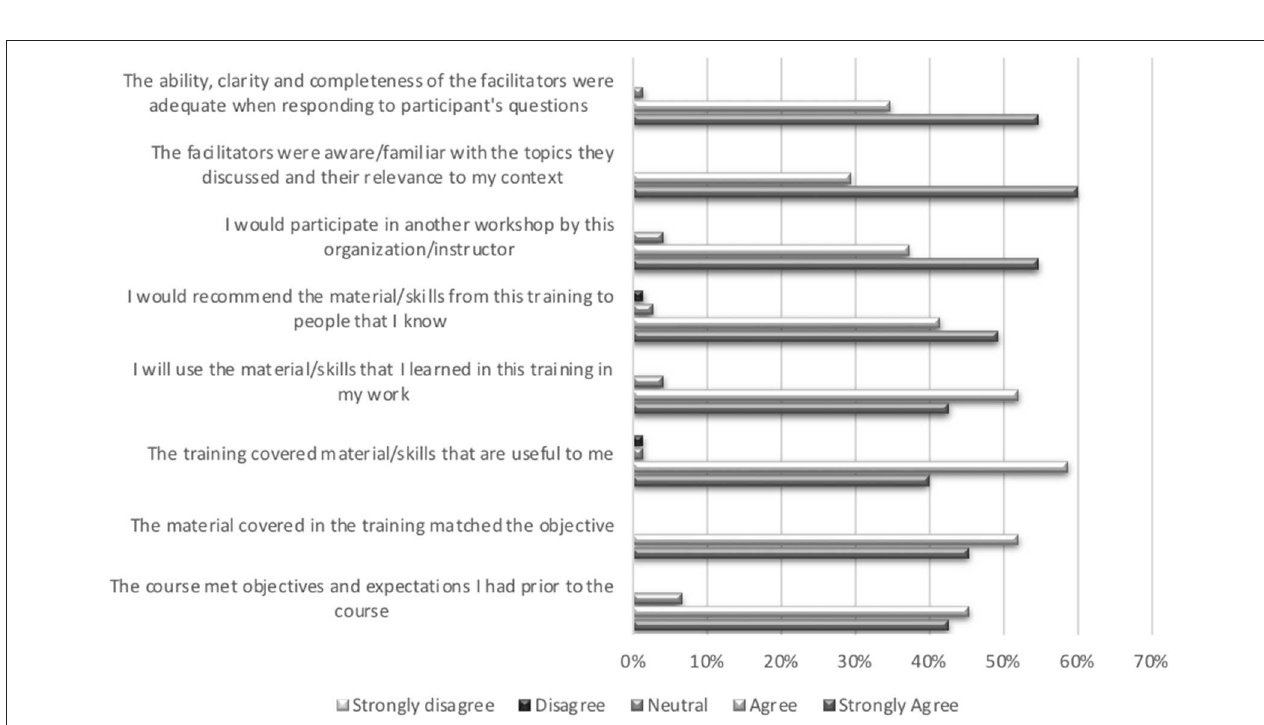
FIGURE 2 | Participant evaluation of the facilitation and content of the course.